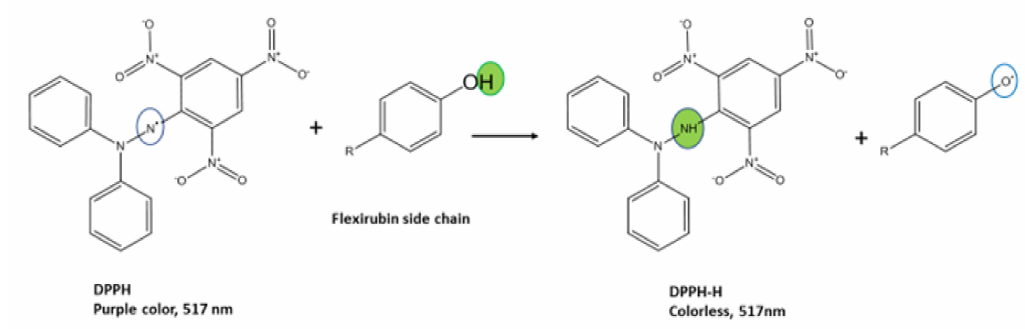
Figure 2. The reaction schemewith flexirubin reduction in the DPPH assay was proposed using Chem Bio Draw Ultra 12.0.